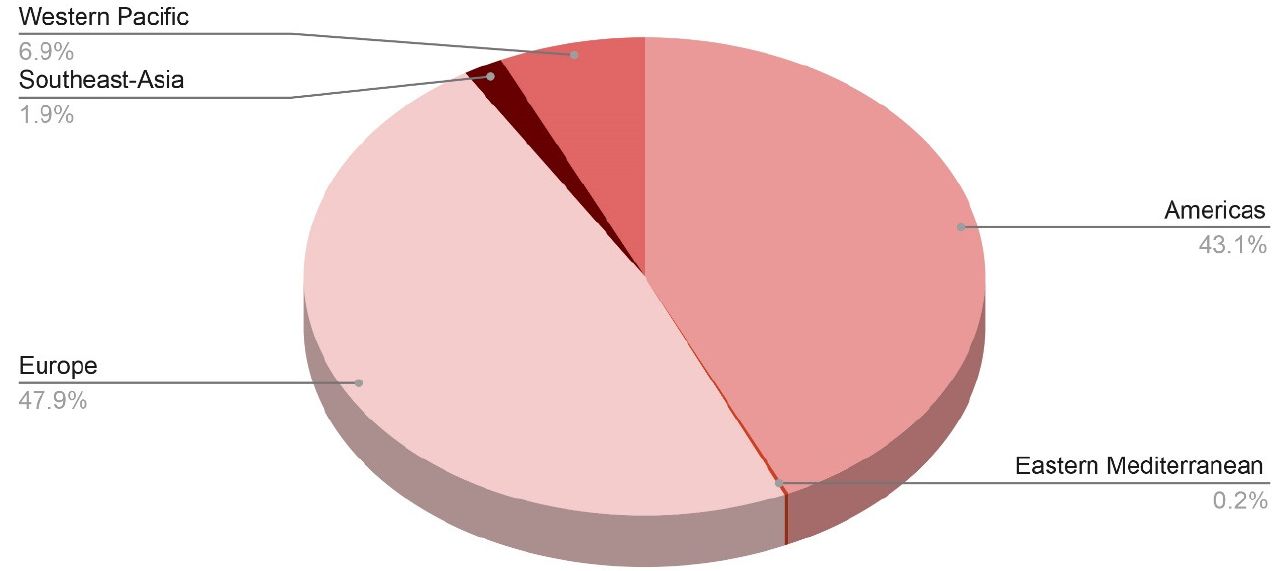
Figure 2. Distribution of probable cases of severe acute hepatitis of unknown origin across the WHO regions.